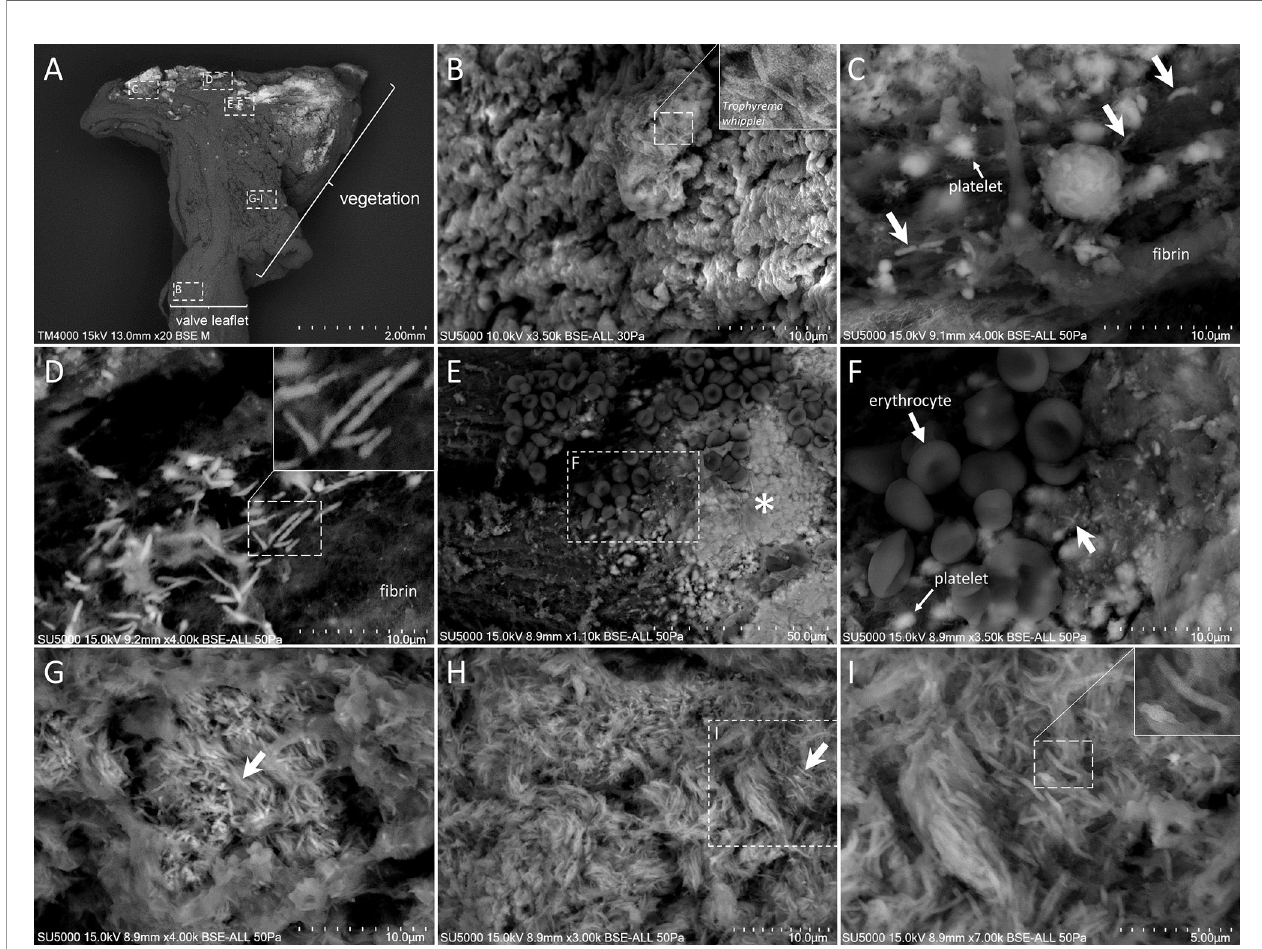
FIGURE 2 | Scanning electron microscopy of Tropheryma whipplei vegetation. (A) Low-magni fi cation view of the whole cardiac biopsy piece along its deepness, with vegetation (right) superposed to valve lea fl et (left). (B) Zoom-in image of the [B] boxed region in (A) showing a cluster of extracellular T. whipplei cells embedded in the valvular tissue. (C) Zoom-in image of the (C) boxed region in (A) showing extracellular T. whipplei cells (bold arrows) disseminated in a network of thick fi brin bundles and platelets (thick arrow). (D) Zoom-in image of the (D) boxed region in (A) with extracellular T. whipplei cells located in a fi shnet-like network of fi brin fi laments. (E, F) Zoom-in image of the (E, F) boxed region in (A) containing erythrocytes (E, F) , isolated or aggregated platelets ( E, F , *), fi brin, and extracellular T. whipplei cells (arrows). (G – I) Zoom-in image of the (G – I) boxed region in (A) depicting a more central region of the vegetation with numerous T. whipplei cells, intermingled with an amorphous matrix and focally organized (G) or more broadly distributed (H, I)